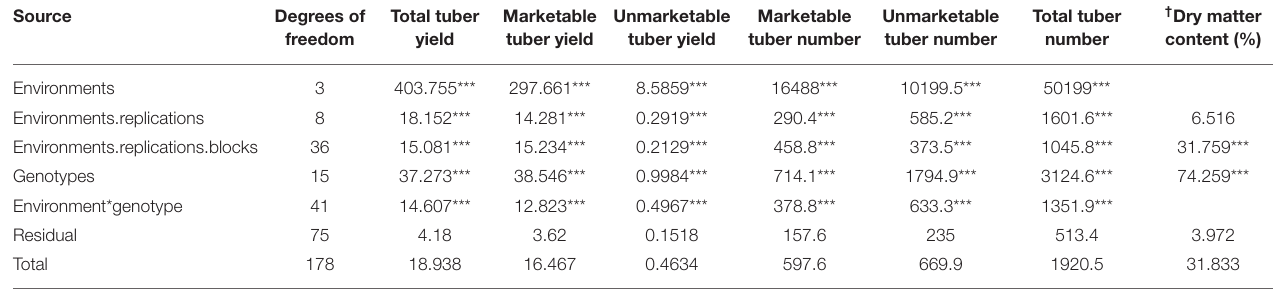
TABLE 1 | Mean squares from across-environment ANOVA.